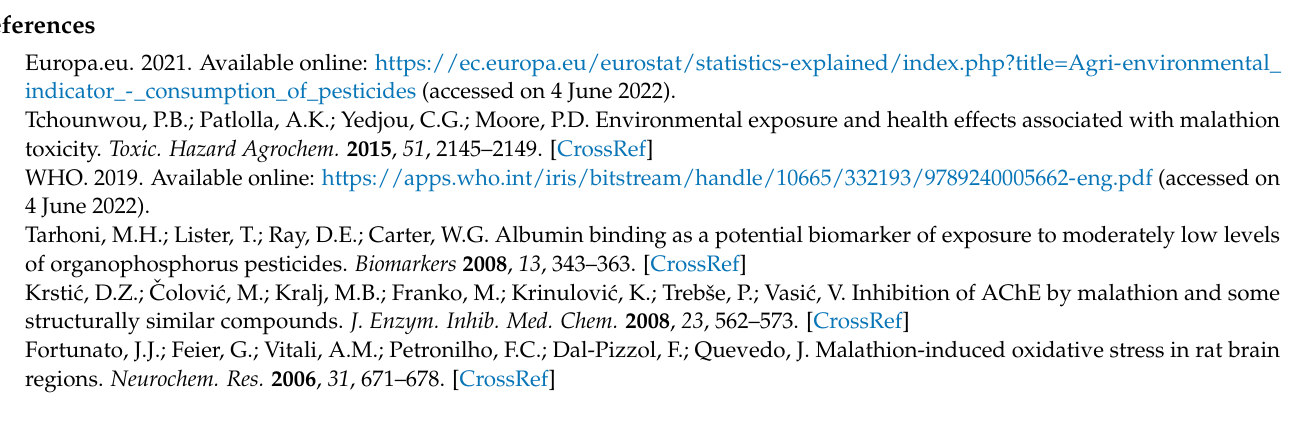
Supplementary; Table S1: Association of pesticide-induced inhibition of acetylcholinesterase and neuropathy target esterase with pesticide dose and brain region; Table S2: Pesticide effects on mitochondrial complex I and complex III